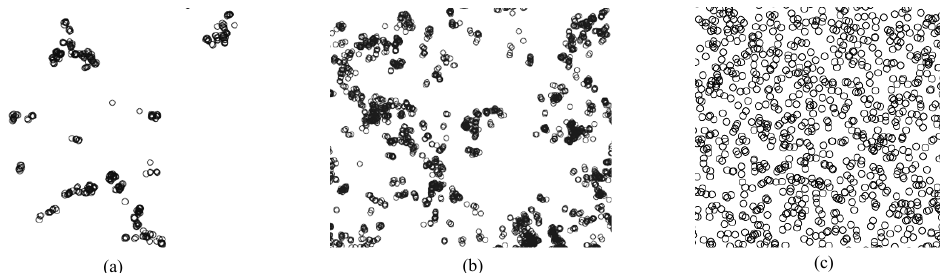
Figure 2. Fractal ( a ), mesofractal ( b ), and uniform Poisson set ( c ) (Monte Carlo